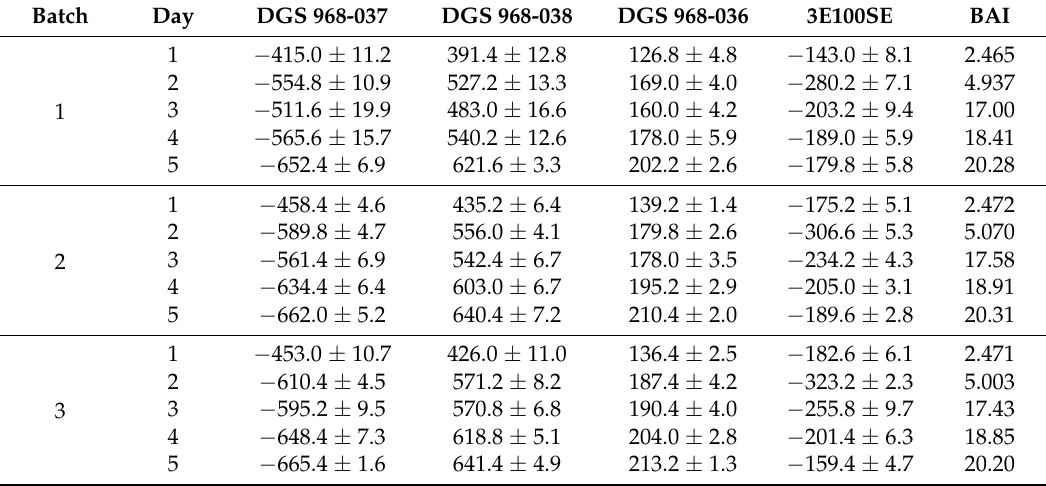
Table 2. Averaged EC sensor response values ± standard deviationand corresponding